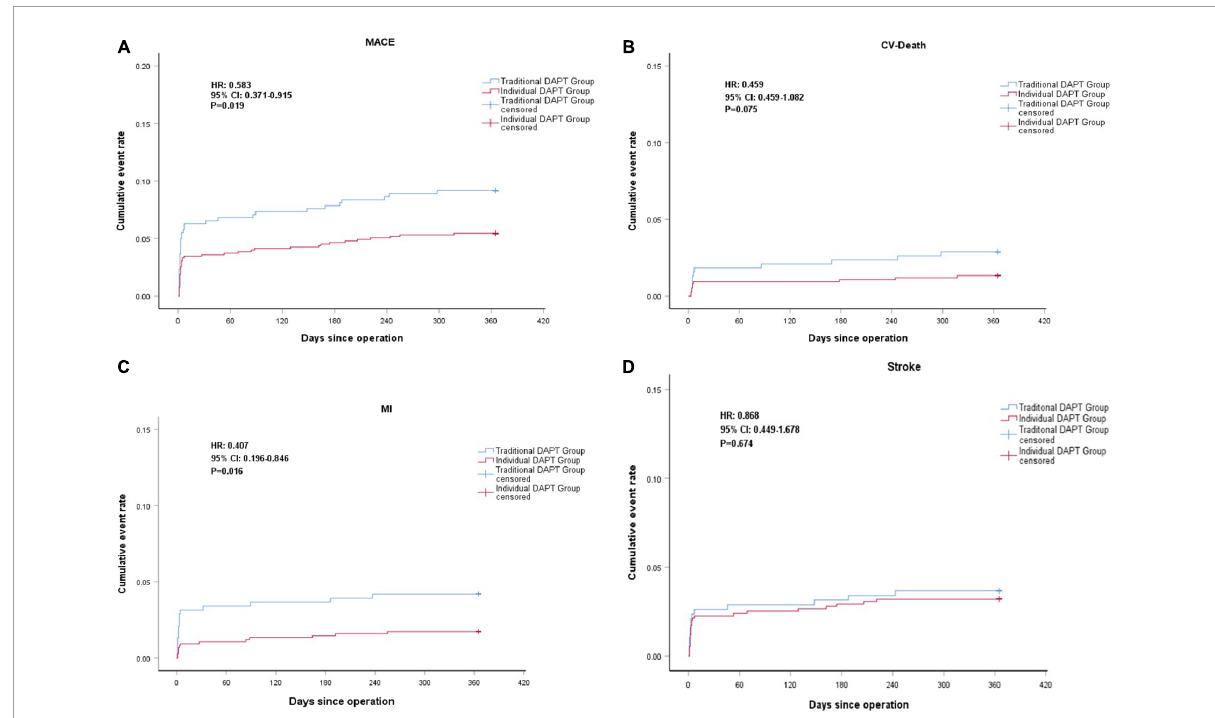
FIGURE3 Kaplan-Meier curve of major adverse cardiovascular events (MACE) (A) , Cardiovascular (CV)-Death (B) , MI (C) , Stroke (D) during the 1 year follow-up.